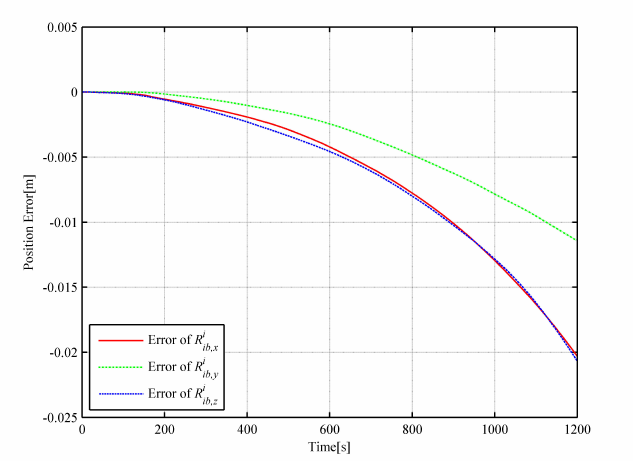
Figure 8. Curve of position error (based on